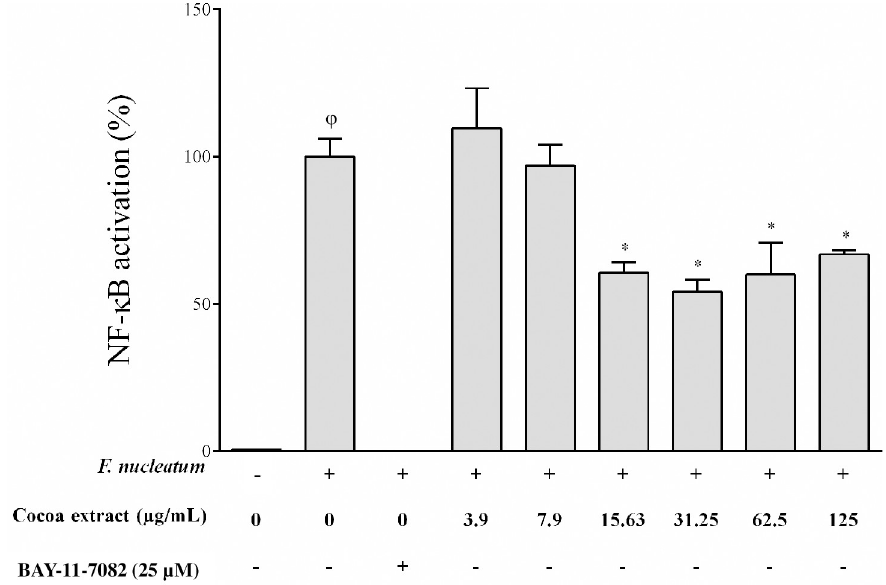
Fig 4. Effect of the cocoa extract on the activation of the NF- κ B signaling pathway induced by F . nucleatum (MOI = 100). A value of 100% was assigned to the activation obtained with F . nucleatum in the absence of the cocoa extract. The commercial inhibitor BAY-11-7082 was used as a positive inhibitory control. φ , significant increase compared to the control (no F . nucleatum stimulation). � , significant inhibition ( p < 0.01) compared to the control (no cocoa